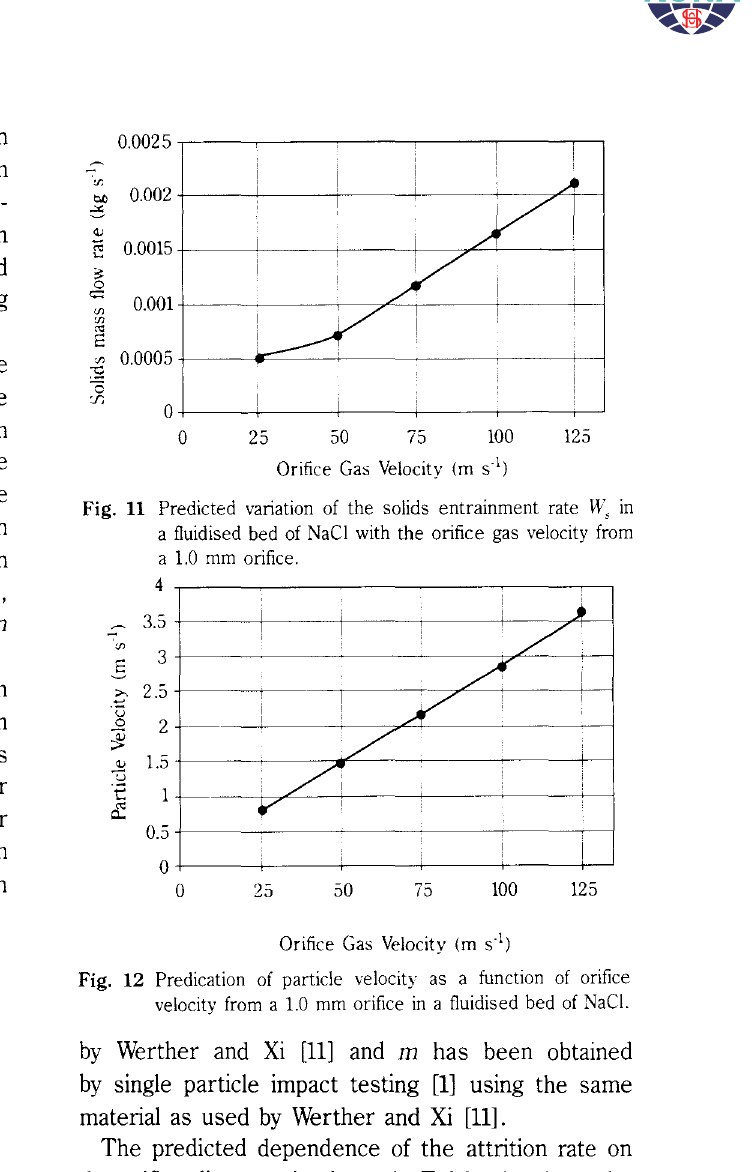
Table 4. Hydrodynamic and attrition parameters for